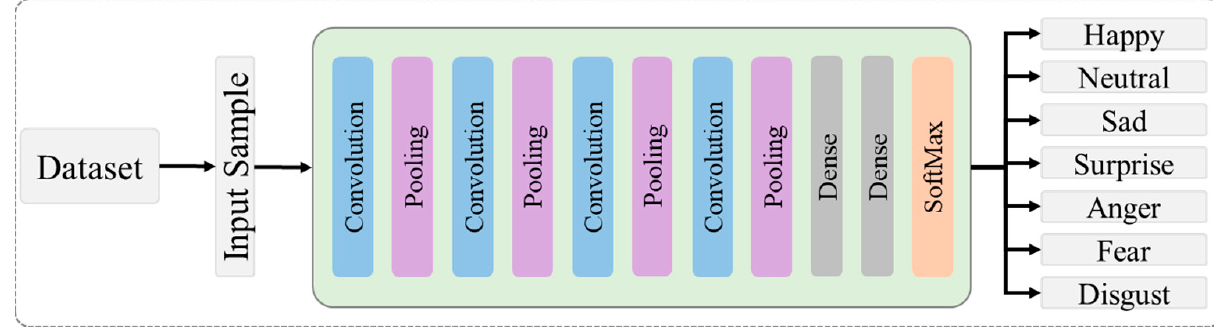
Figure 1. A detailed view of the proposed facial recognition model.